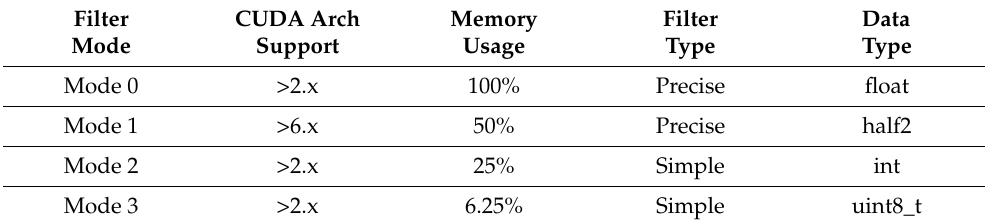
Table 1. NanoMap filter